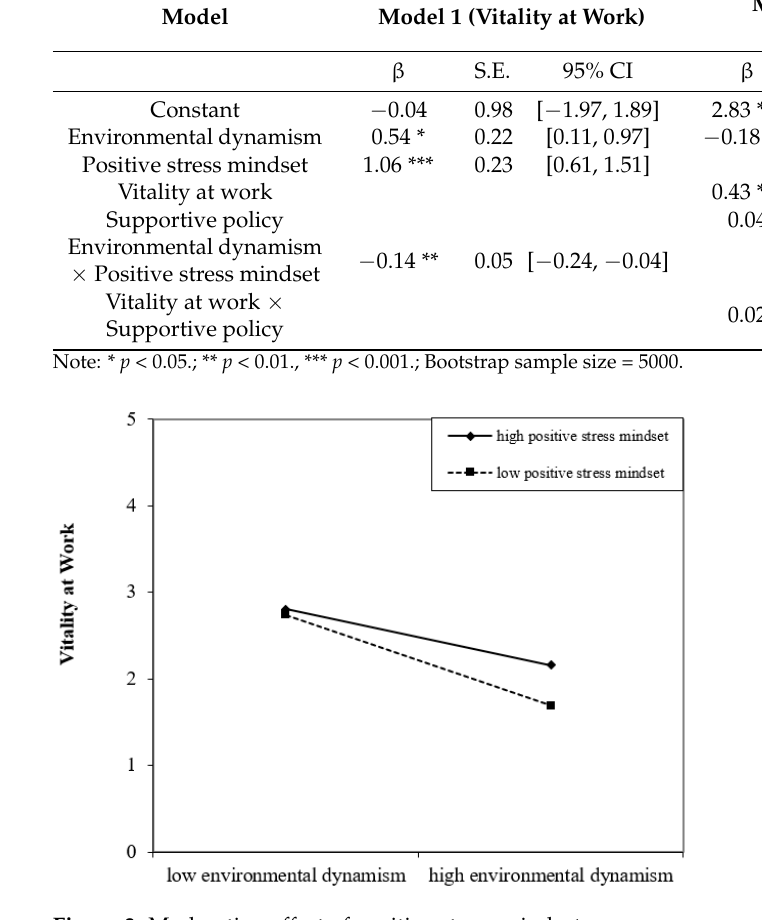
Figure 3. Moderating effect of positive stress mindset. Table 5. Estimates and confidence intervals for the moderating roles.